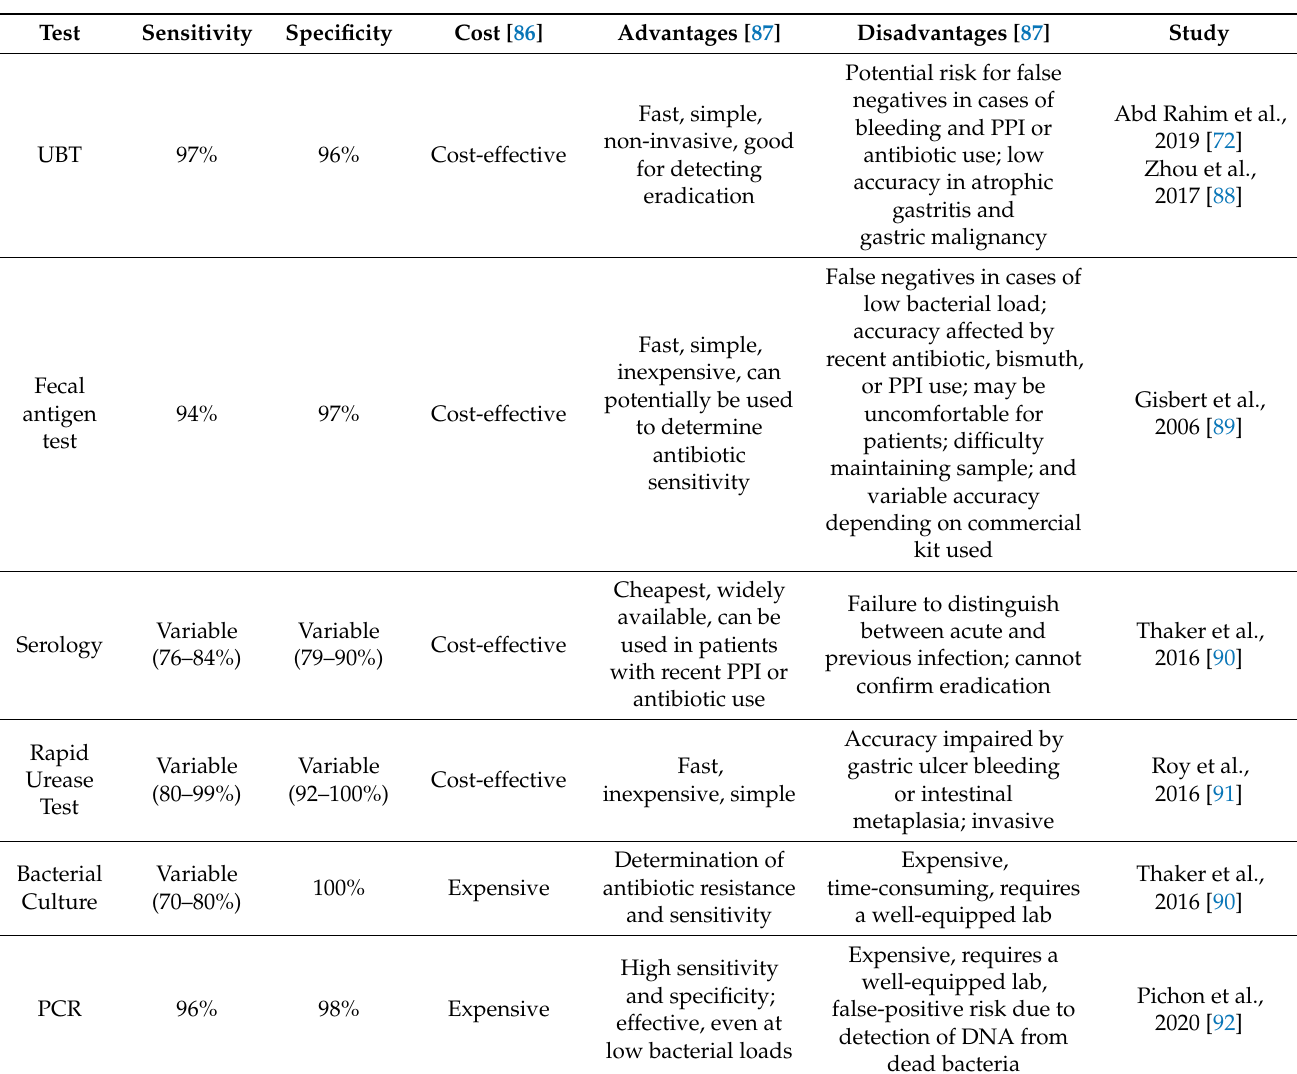
Table 1. Sensitivities and specificities of various diagnostic